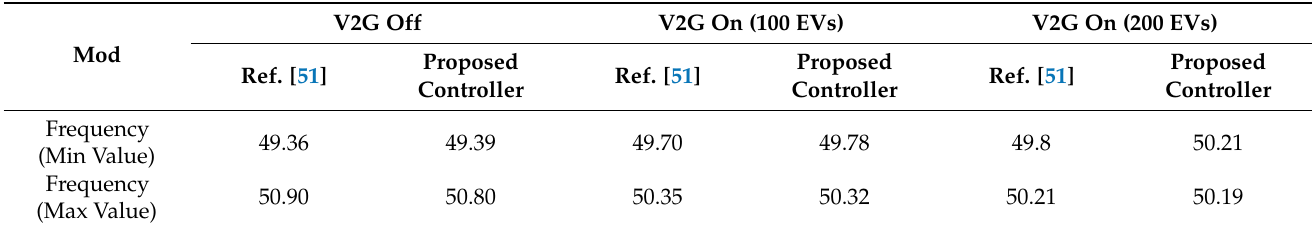
Table 5. Comparison of results for three separate cases in scenario 2 using the proposed controller compared to those of